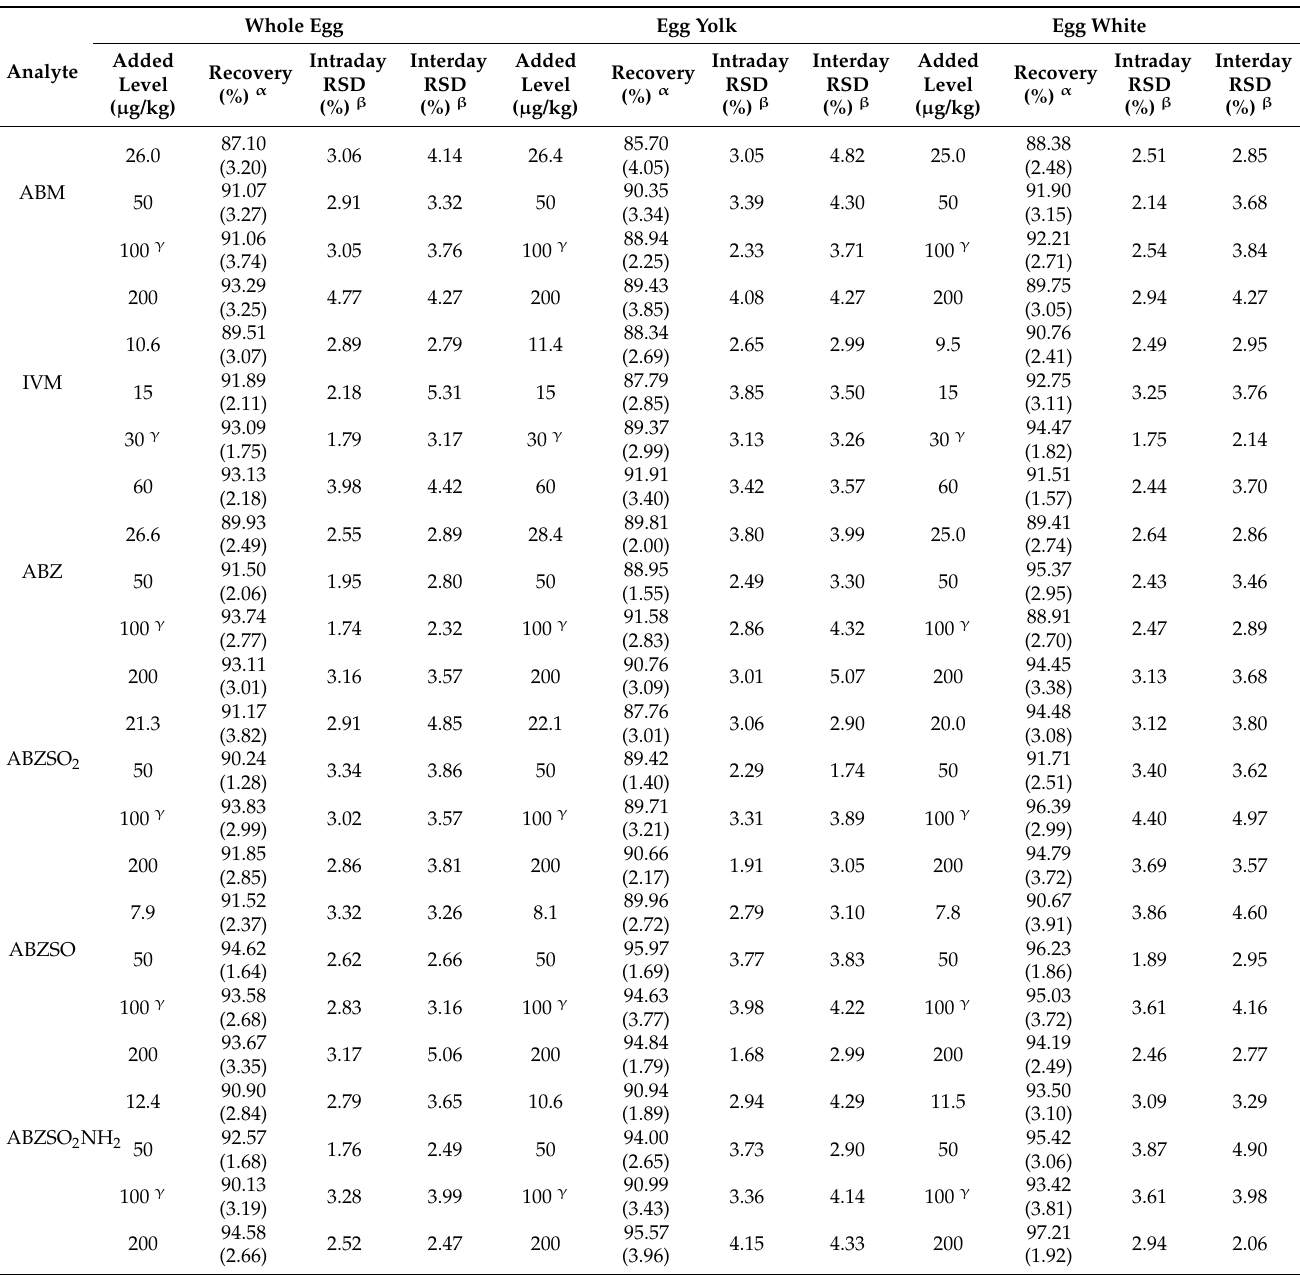
Table 4. Mean recoveries and precision of six